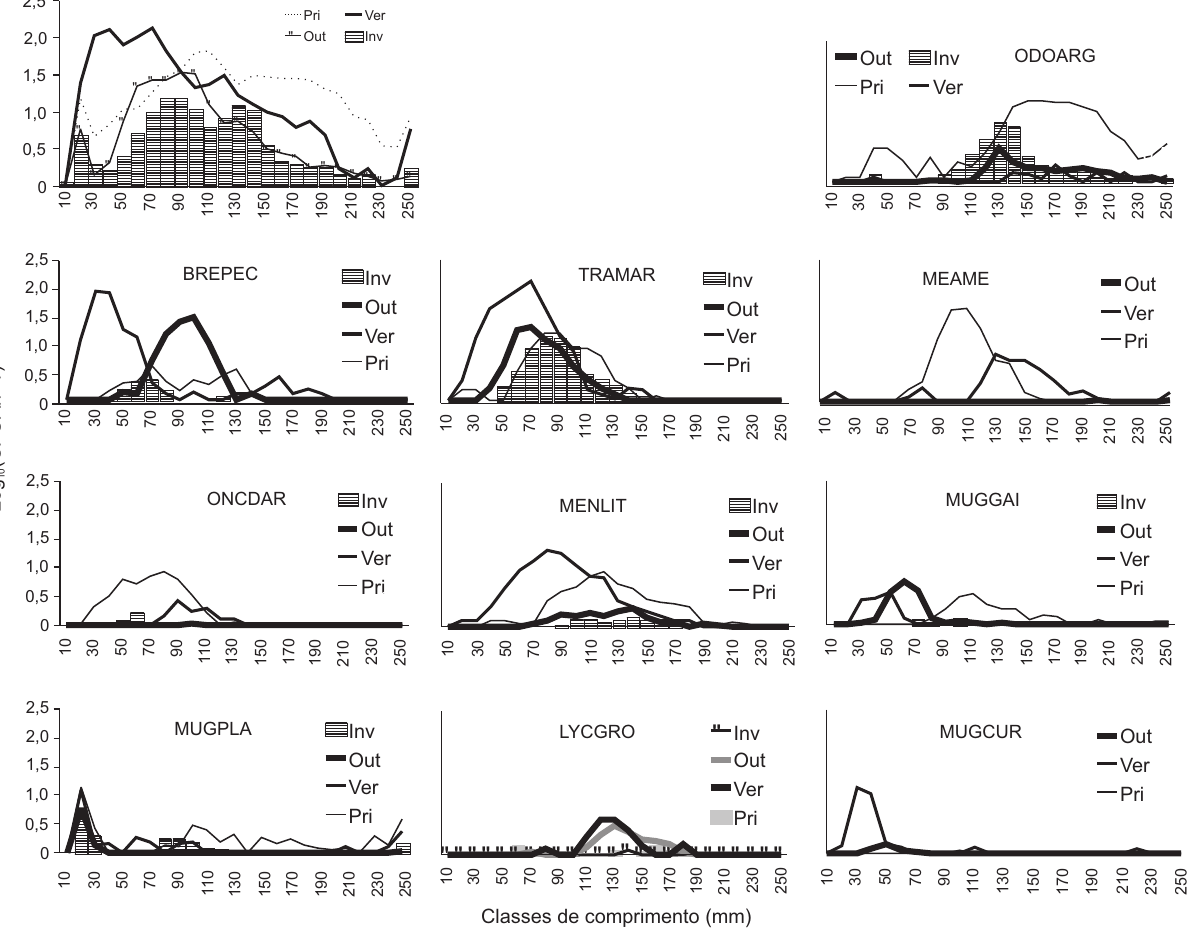
Figura 8. Distribuição geral da CPUA-CC e das 10 principais espécies por estação do ano (ver código das espécies na tabela